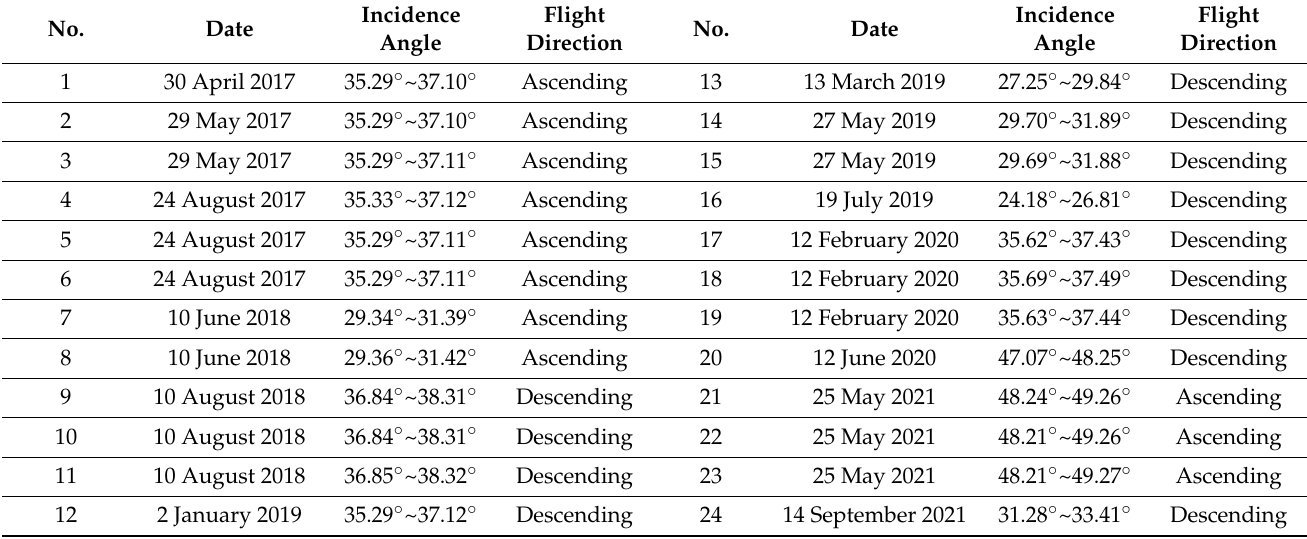
Table 1. List of GF-3 PolSAR Table 1. List of GF ‐ 3 PolSAR data.